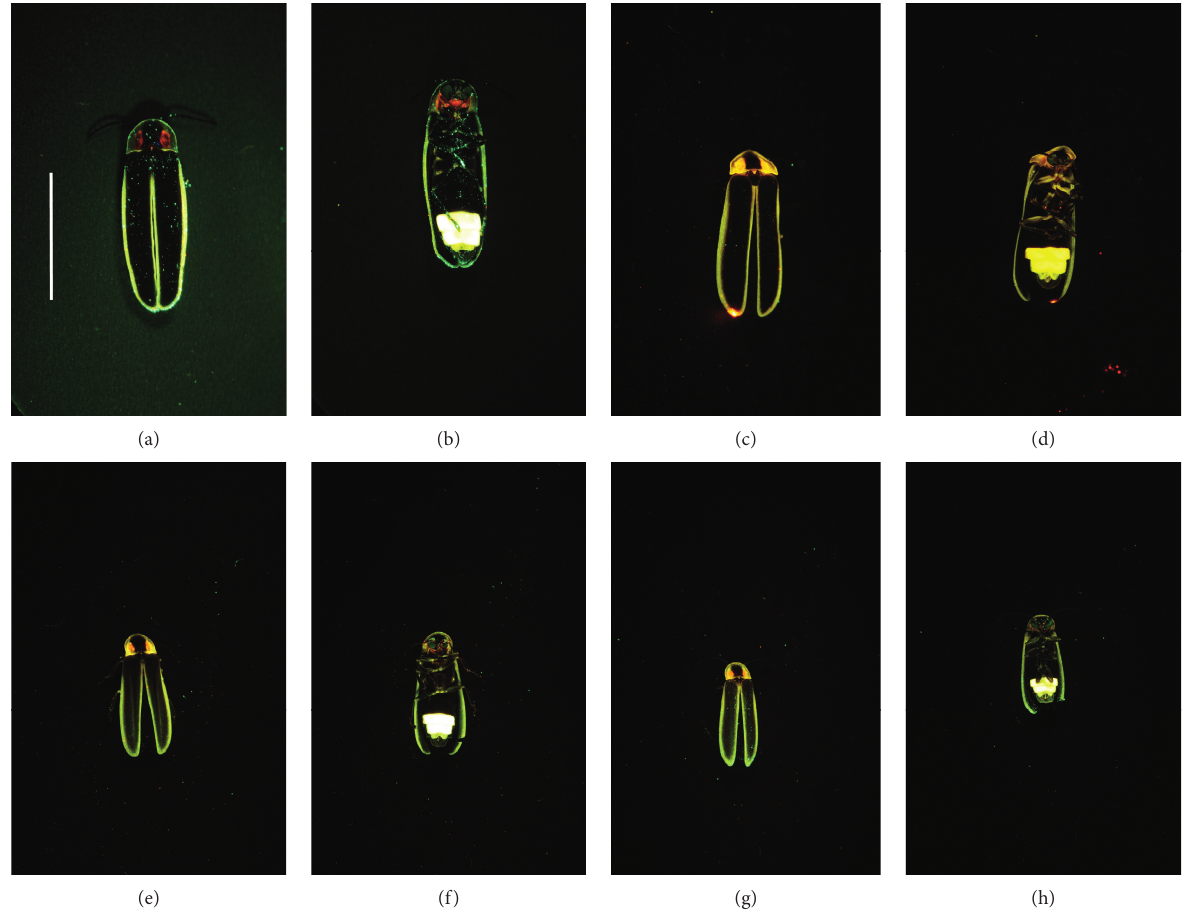
Figure 2: Dorsal and ventral aspects of Photinus obscurellus (a and b), Photinus greeni (c and d), Photinus ignites (e and f), and Photinus aquilonius (g and h). Specimens were photographed under white light, and under blue light using a yellow filter. Blue light was supplied by a NIGHTSEA Model SFA Royal Blue light emitting at 440–460nm, using a NIGHTSEA yellow barrier filter to screen. Scale bar represents approx.